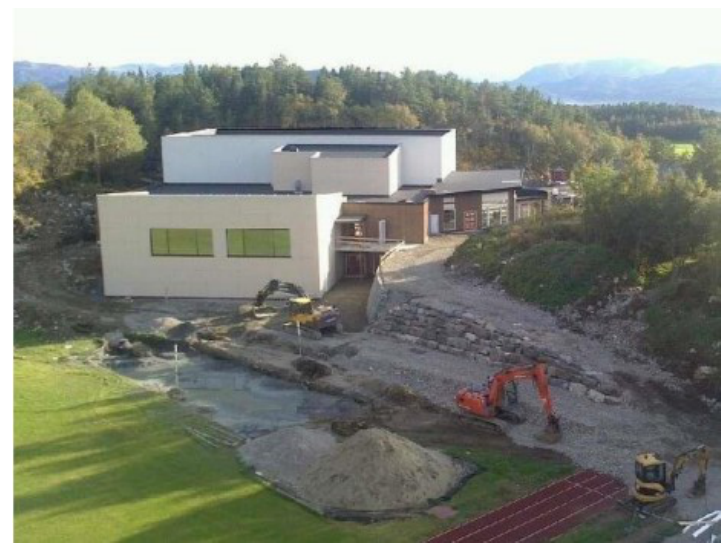
Figure 3. The northern façade of the